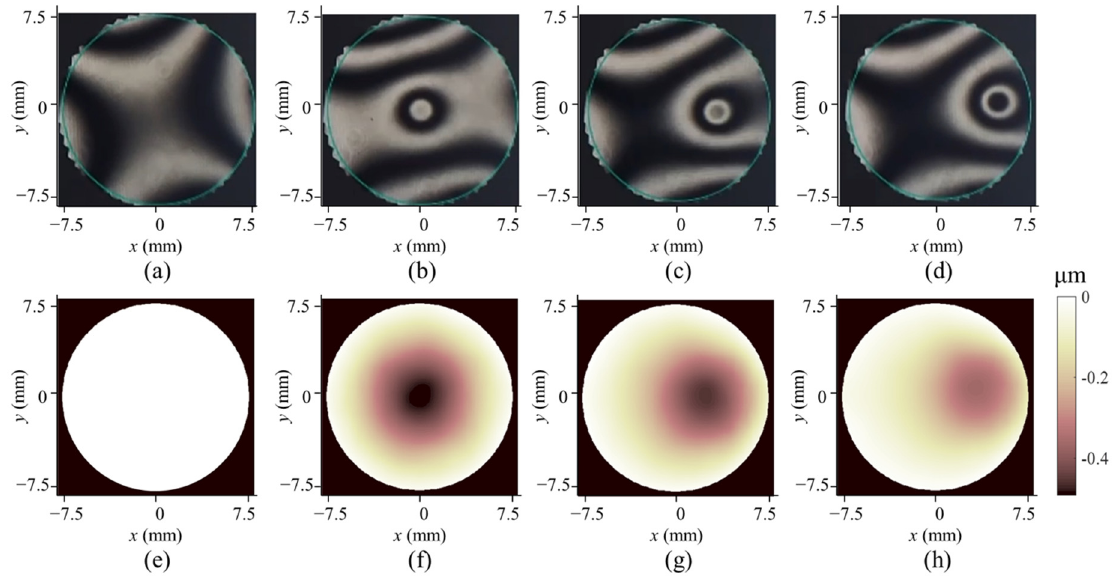
Figure 6. Four frames of typical interferograms and the corresponding dynamic deformations measured with DeSDIC. ( a )( b )( c )( d ) are the interferograms and ( e )( f )( g )( h ) are the measured deformations. ( a ) is the interferogram corresponding to the original DM shape.